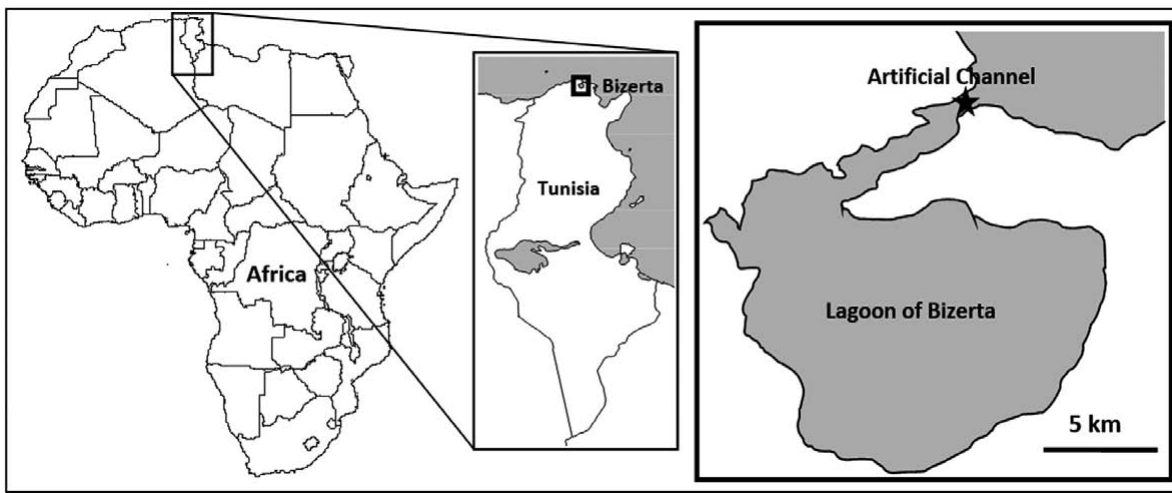
Fig. 1. – Map of Tunisia and sampling site of Stramonita haemastoma in the channel of